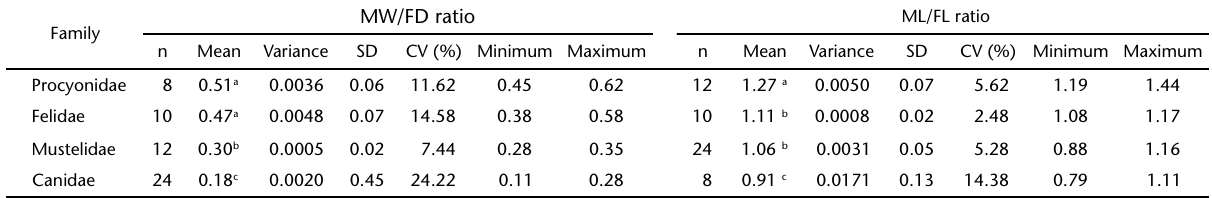
Table II. Descriptive statistics regarding the MW/FD and ML/FL ratios obtained for the thoracic limbs (n = 54) of carnivorans specimens grouped by families (SD) Standard deviation, (CV) Coefficient of variation .